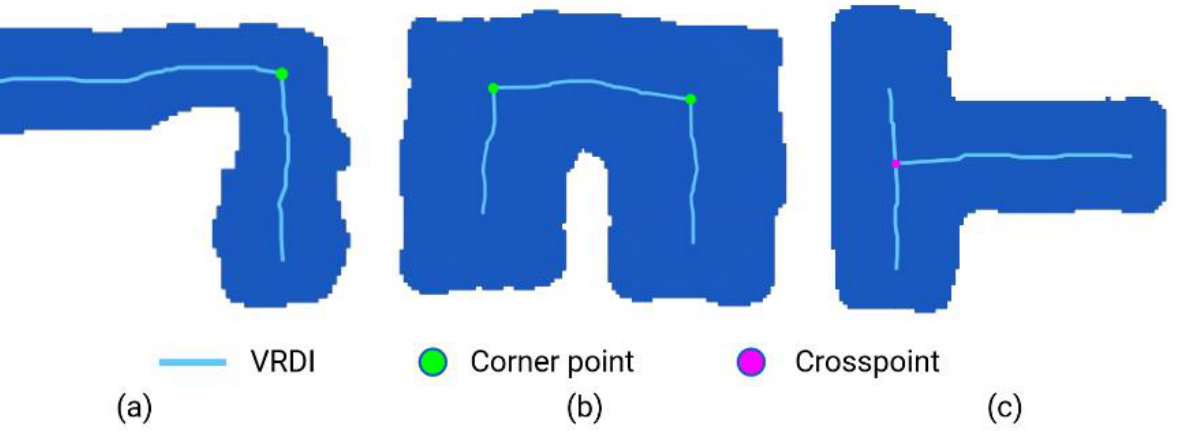
Figure 14. Skeleton line segmentation. ( a ) L-shaped building with one corner point; ( b ) C-shaped building with two corner points; ( c ) T-shaped building with one crosspoint.